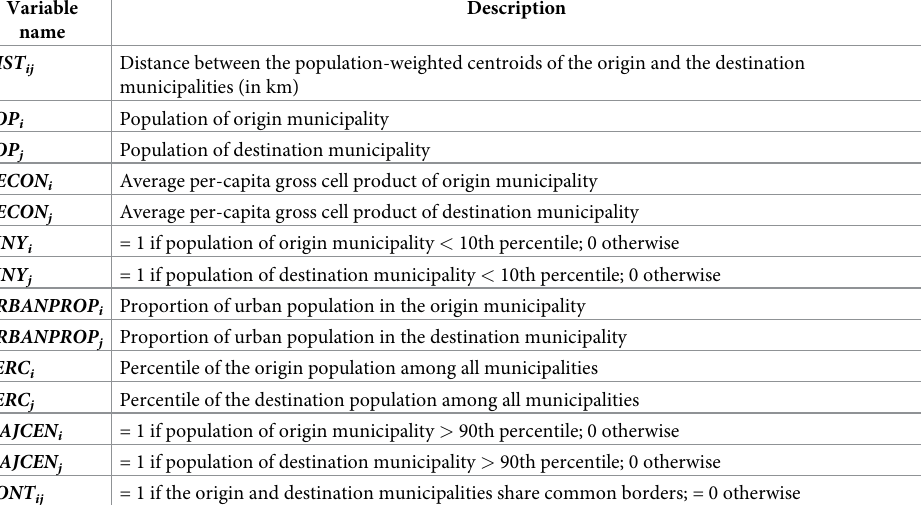
Table 1. List of normalized covariates used in selecting our migration model and their corresponding